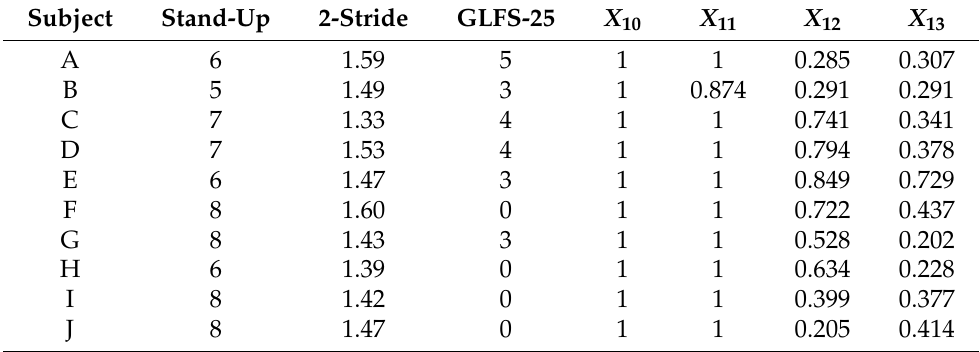
Table 7. Results of the STBLS assessment and one-leg standing measurement ( X 10 to X 13 ) for 10